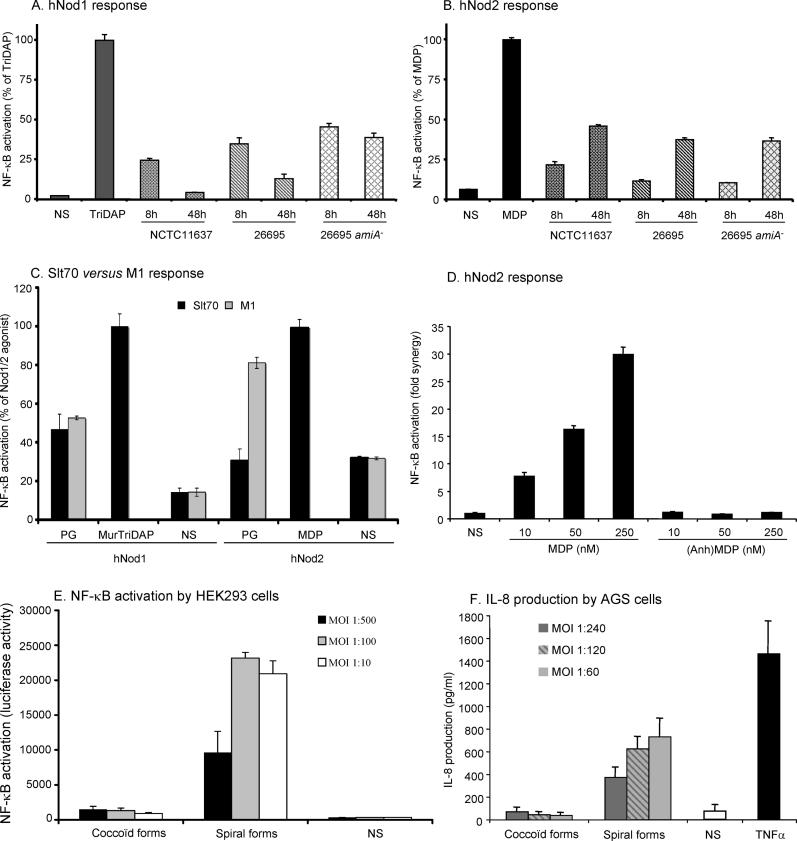
hNod1- and hNod2-Dependent Activation of NF-κB by H. pylori PG(A and B) PG samples from strain NCT11637, strain 26695, and the isogenic amiA mutant prepared after 8 h and 48 h of growth, were digested with M1 (mutanolysin) to generate muropeptides and used to stimulate hNod1 (A) and hNod2 (B).(C and D) PG samples were also digested with recombinant Slt70 from E. coli to generate anhydromuropeptides, used to stimulate hNod1 and hNod2, and compared to M1-generated muropeptides (C). hNod1 and hNod2 agonists were used at 10 nM and PGs at 0.3 μg/ml. Finally, purified GM-dipeptide and its anhydrous derivative G(anh)M-dipeptide were also tested for their ability to stimulate hNod2 (D).(E) H. pylori at different growth stages (spiral versus coccoid) and different multiplicity of infection (MOI) were used to stimulate the HEK293T cells, and NF-κB activation was determined.(F) The same experiment as in (E) was performed with the AGS gastric epithelial cell line, and IL-8 secretion was determined. TNF-α (20 ng/ml) was used as a positive control.MDP, muramyldipeptide; NS, nonstimulated; TriDAP, L-alanyl-D-glutamyl-mesoDAP.